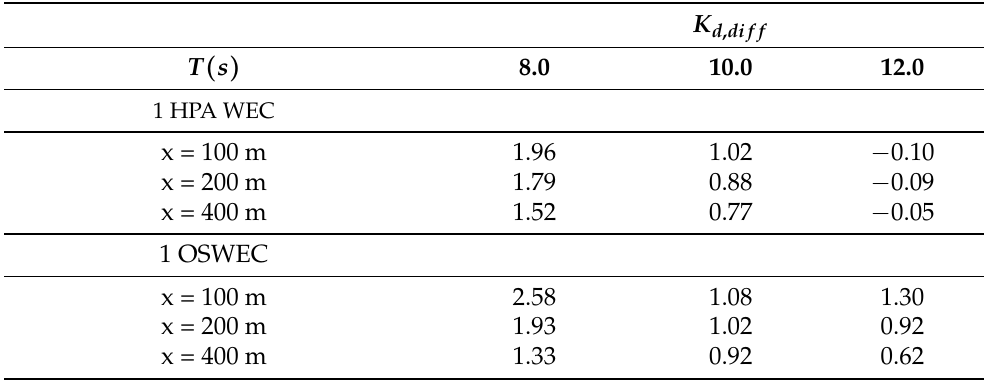
Figure 5. Kd disturbance coefficient results for the MILDwave-NEMOH coupled model and the MILDwave sponge layer technique along one longitudinal cross-section at the centre of the domain for a single OSWEC interacting with regular waves of H = 2 m and T = 8 s. The coupling region is filled in grey colour and includes the WEC’s cross-section indicated by a black vertical area. Incident waves are generated from the left to the right. Table 1. K d , dif f (%) at x = 0 m for three different distances in the lee of the WEC (y = 100, 200 and 400